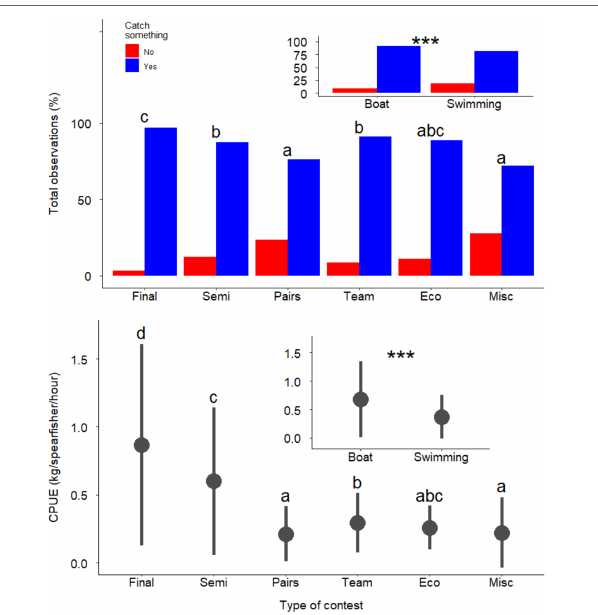
FIGURE 5 | Catch per unit effort (kg/spearfisher/h) for each type of tournament and for each type of category (inlet) of Italian marine spearfishing tournaments from 2009 to 2020. Upper panel represent chances to catch something, while lower panel represents quantitative measures when at least one fish was caught. Points represent mean values and vertical lines represent the standard error. Letters in the main plot indicate the output of the Tukey post hoc test (a < b < c < d). *** in the inlet indicate significant differences with p < 0.001 (N Final = 533; N semi = 706; N Pairs = 339; N Teams = 241; N Eco = 9; N Misc = 254; N Boat = 1102; N Swimming = 980).